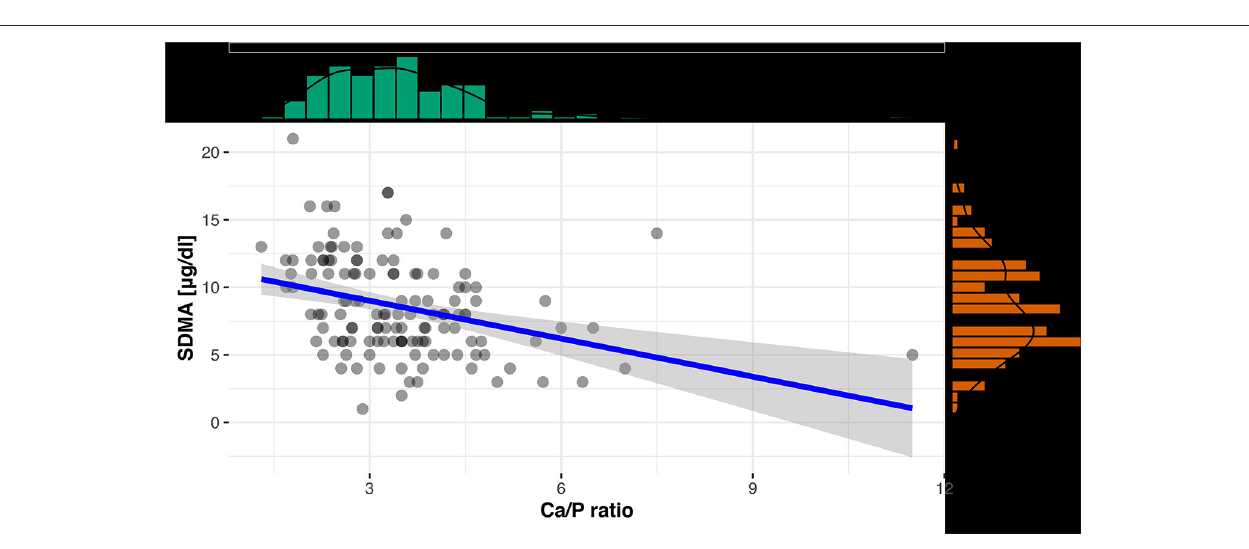
FIGURE 4 | Scatterplot with regression line and marginal distribution: correlation between SDMA and Ca/P